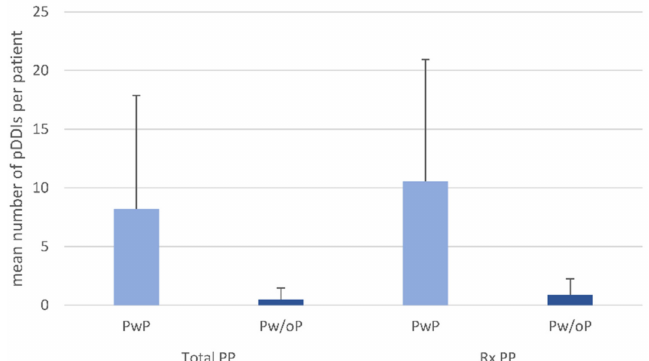
Figure 1. Average number of pDDIs per patient with MS, stratified by PP status and type of PP. The patients were classified by PP status according to total PP (intake of at least five drugs of any kind) and Rx PP (intake of at least five drugs only available on prescription). Standard deviations are displayed as error bars. The average number of pDDIs was higher in PwP compared with Pw/oP, for both total PP (8.2 ± 9.7 versus 0.5 ± 1.0) and Rx PP (10.5 ± 10.4 versus 0.9 ± 1.4). MS—multiple